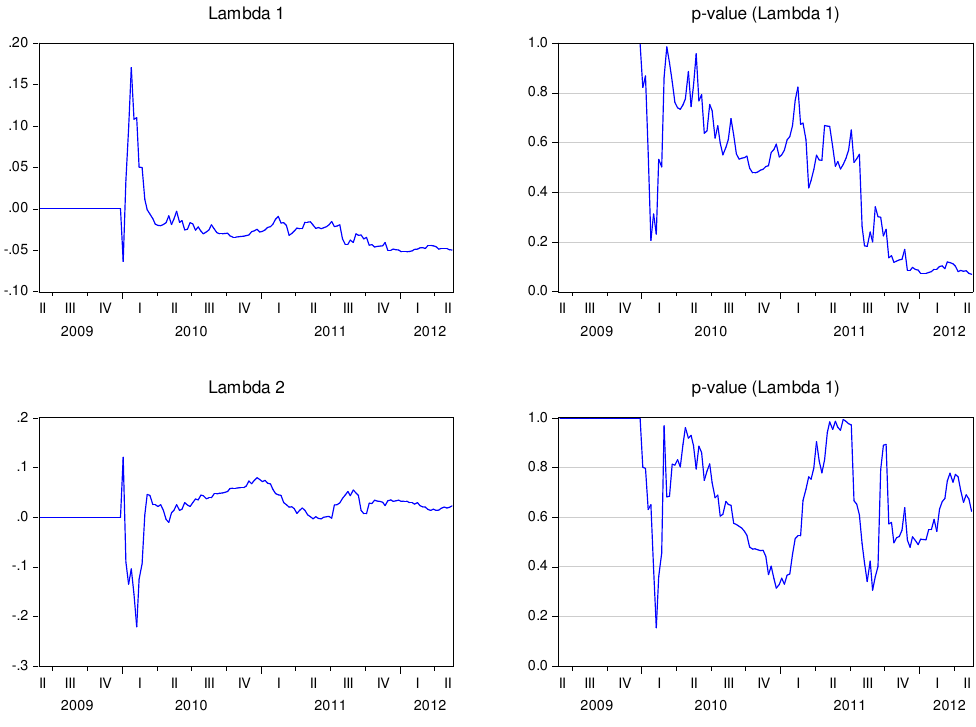
Figure 3. Recursive estimation of the speed adjustment parameters—Germany.